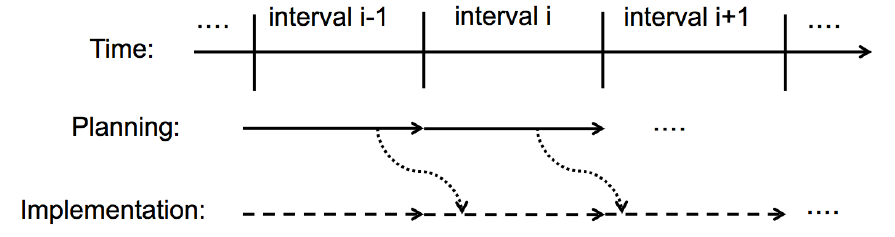
Figure 6. The microgrid operation